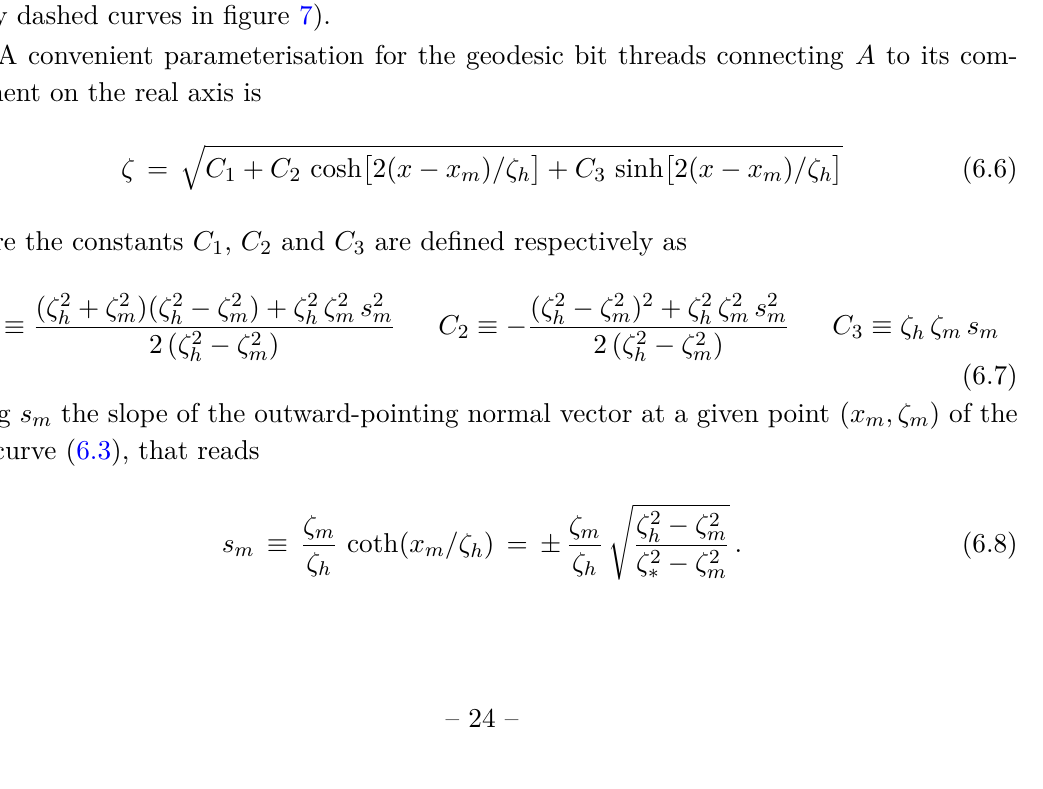
In figure 7, the RT curve (6.3) corresponds to the red solid curve in the yellow region. This RT curve does not coincide with the one discussed in the last paragraph of section